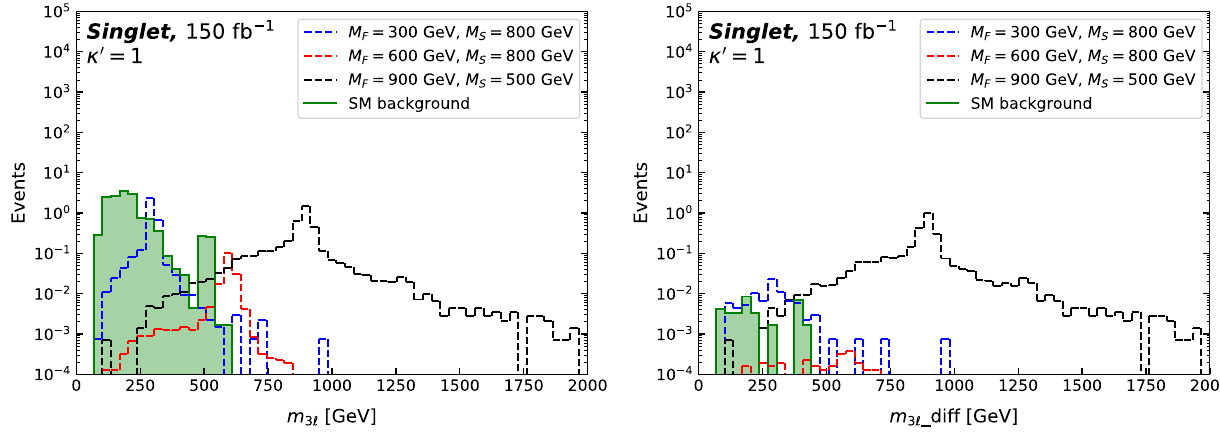
Fig. 15 Trilepton invariant mass distributions m 3 (cid:5) and m 3 (cid:5) _diff for the singlet model with κ (cid:4) = 1 after detector simulation, for the full Run 2 √ s = 13 luminosity 150 fb − 1 and